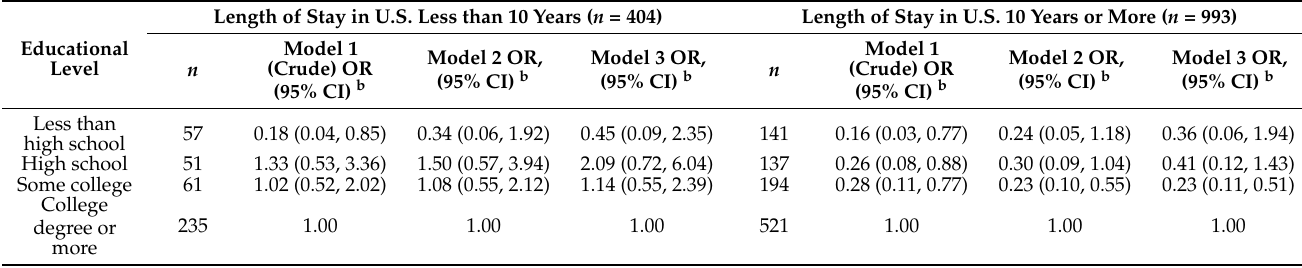
Table 3. Association between education and ideal CVH a by the length of stay in the U.S. among Asian Americans, NHANES, 2011–2016 (n =